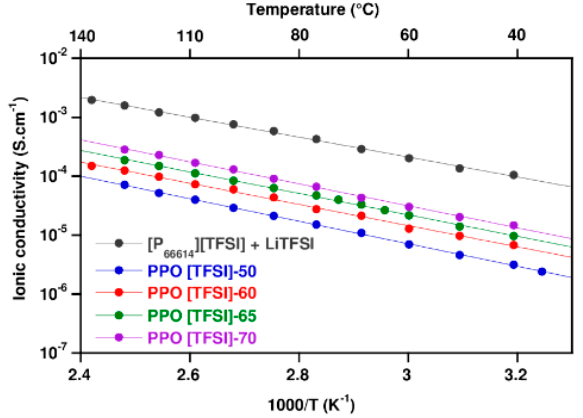
Figure 6. Ionic conductivity of gelled electrolyte with different amount of electrolyte ([P 66614 ][TFSI] with 0.75 M of LiTFSI).